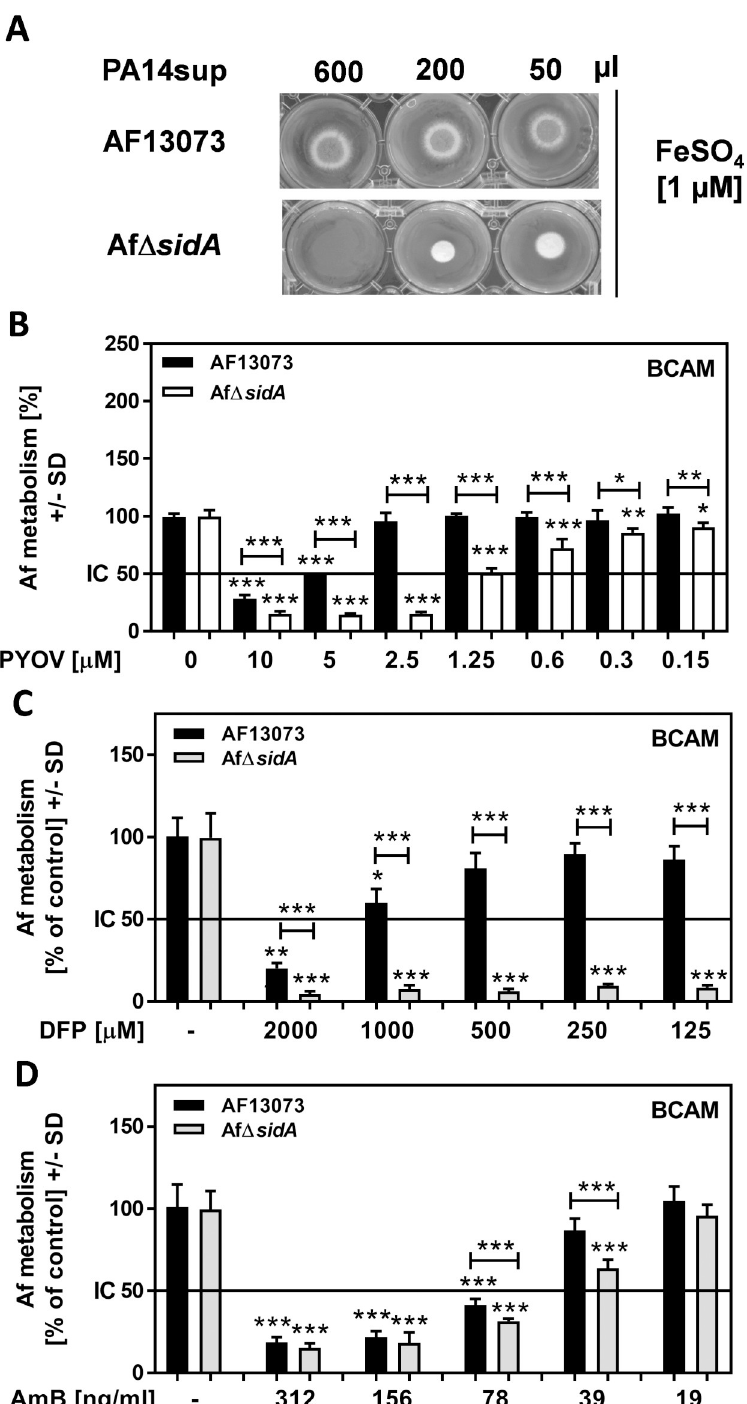
Fig 5. Absence of hydroxamate siderophores sensitizes A . fumigatus . A: RPMI was inoculated with PA14 [5x10 7 cells/ml], incubated for 24 hours, and the culture supernatant was sterile filtered. Growth of point inoculated AF13073 or Af Δ sidA (10 4 conidia) on 3 ml solid minimal medium in the presence of 1 μ M FeSO 4 plus 50–600 μ l of the sterile filtered supernatants was compared after incubation for 48 h at 37˚C. B: Af Δ sidA (white bars) or AF13073 (black bars) BCAM assays were incubated with either RPMI or different concentrations of pyoverdine. Fungal metabolism was measured by XTT assay. Statistics: t-Test. For each fungus RPMI controls were regarded as 100%. RPMI controls for each fungus vs. all pyoverdine concentration. Other comparisons as indicated by the ends of the brackets. C: Wildtype